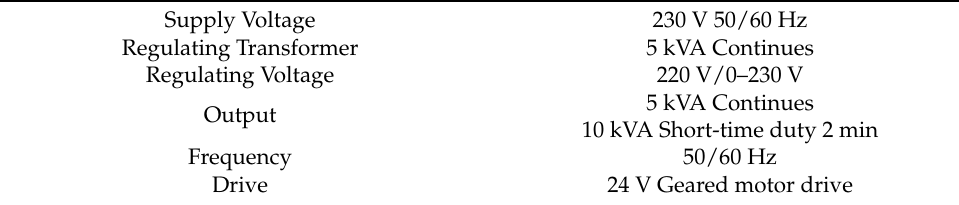
Table 2. Control desk specifications.